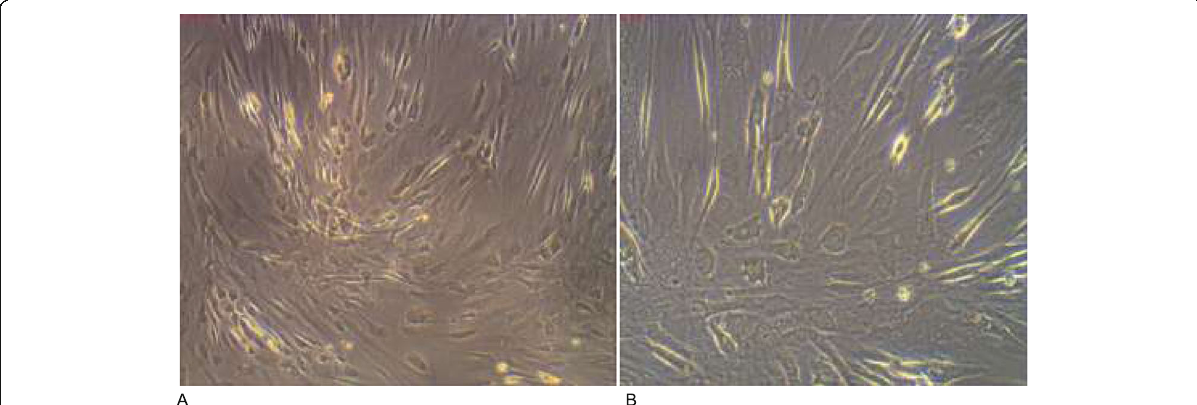
Fig. 2 Differentiation of hMSCs into insulin-producing cells (IPCs). HBM-MSCs at P3 were induced to differentiate into IPCs by an 18-day protocol. a After 14 days of induction, small round cell aggregates were formed. b At day 18 (the end of differentiation), more islet-like clusters and